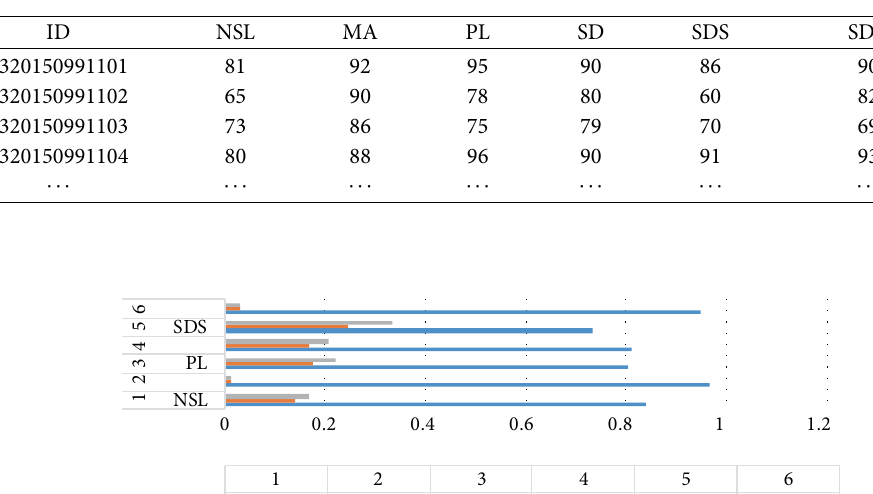
Table 4: Graduate data rating for average scores.